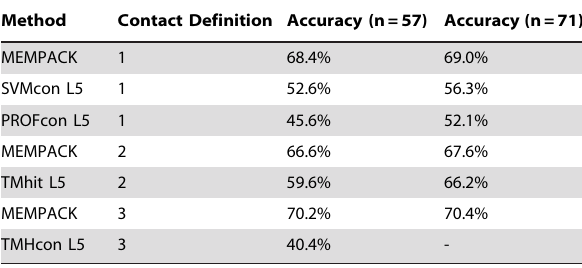
Table 4. Helical packing arrangement decoy discrimination using a data set of 71 sequences with 2 or more TM helices (n=71) and a data set of 57 sequences with 3 or more helices (n=57).